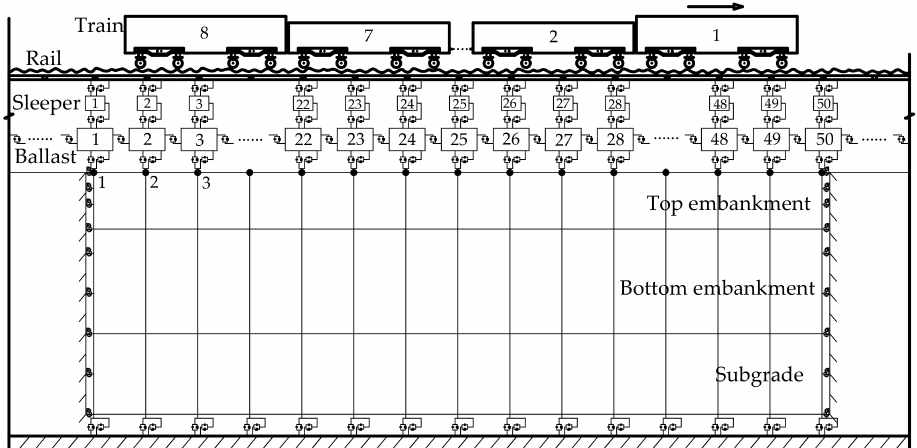
Figure 9. Global configuration of the 3D train-ballasted track-subgrade coupling system.